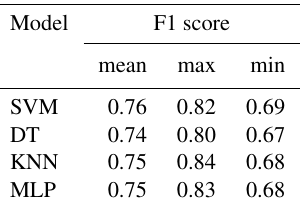
Table 10. F1 scores of the validation phase for SVM, DT, and KNN and MLP models with 100 random training–validation